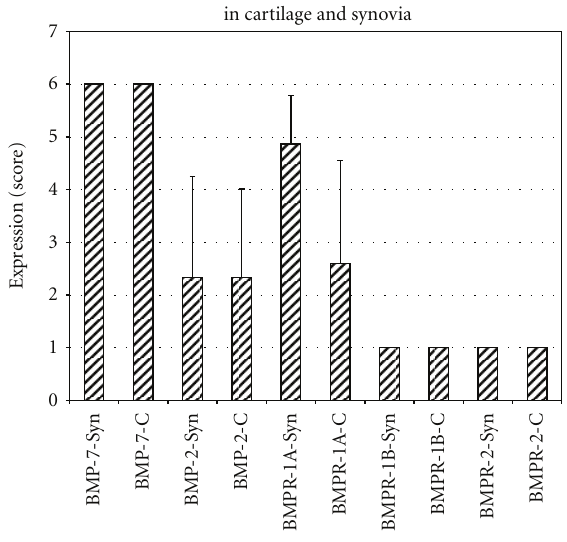
Figure 1: Quantitation of BMP-2, BMP-7, and their receptors in cartilage and